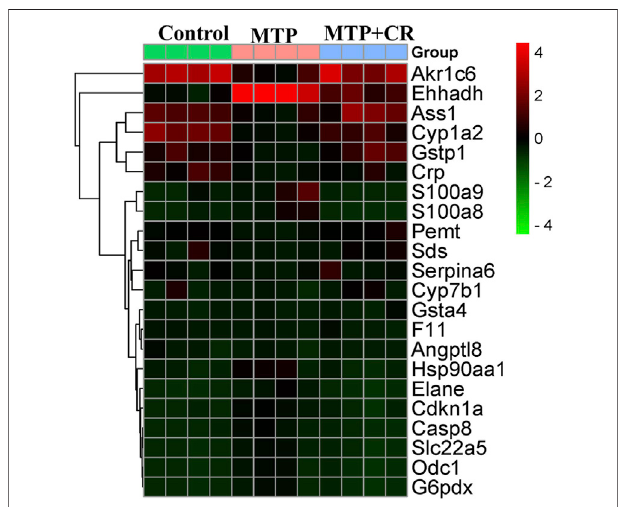
FIGURE 12 | The heat maps of the Top 23 differentially-expressed mRNAs among three groups.